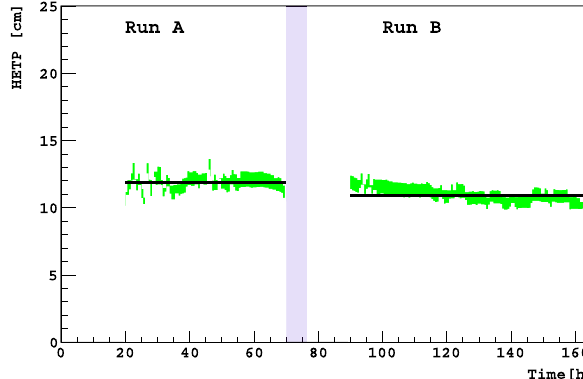
Fig. 16 Reboiler (red) and condenser (blue), isotopic ratio R N timefor 29 N 2 – 28 N 2 distillationintheprototypeplant,afterspectrometer calibration. The bands represents the systematic uncertainty from the spectrometer calibration